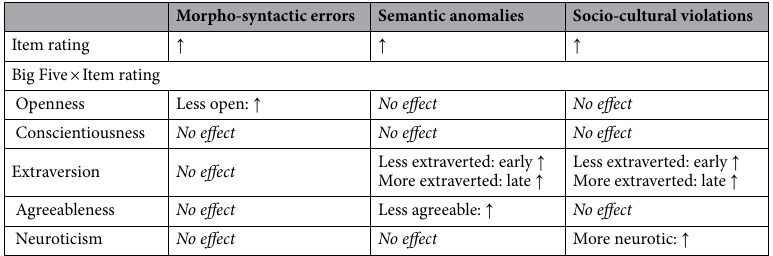
Table 12. Overview of effects of item rating/condition, and interaction effects with Big Five traits on pupil size, as reported in the Results section; a upwards arrow indicates a larger pupil